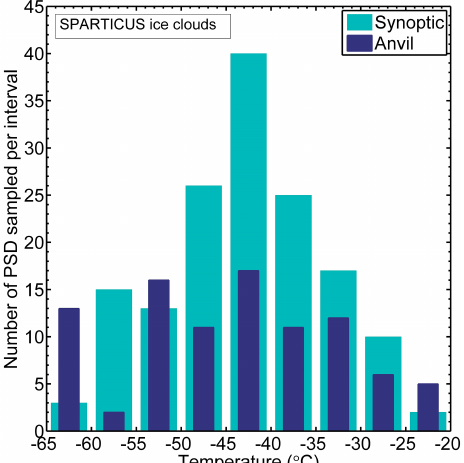
Figure 2. SPARTICUS PSD sampling statistics for synoptic and anvil cirrus clouds where the PSDs have been grouped into temper- ature intervals of 5 ◦